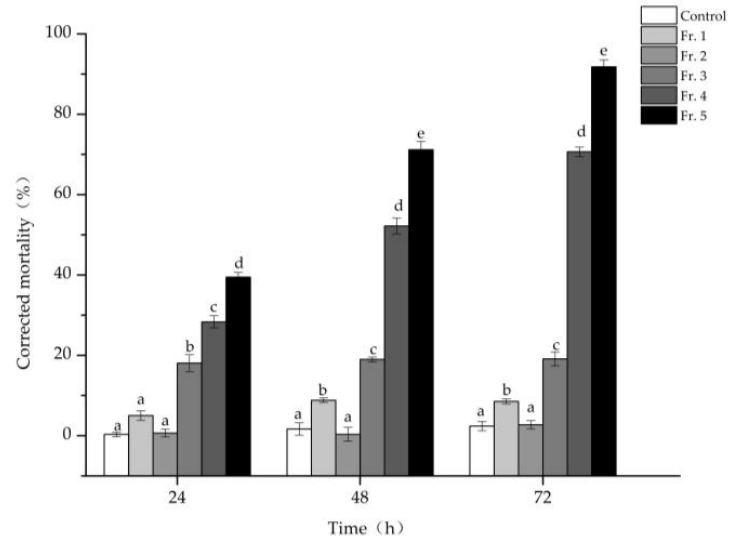
Figure 3. Corrected mortality of PWNs for different fractions. PWNs were treated with 200 μg/mL Fr. 1 - Fr. 5 effluent at 24 h, 48 h, and 72 h, respectively, and the corrected mortality was determined. Mean values were plotted with standard deviations (SD). The control group only contained NB medium. Means with the different letters were significantly different at p < 0.05 based on one-way ANOVA with multiple comparison analysis using the LSD test.